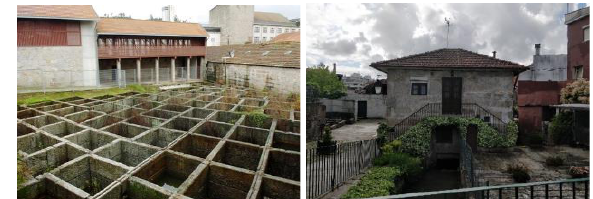
Figure 12. Left: view from Fraterna to the leather tanks.